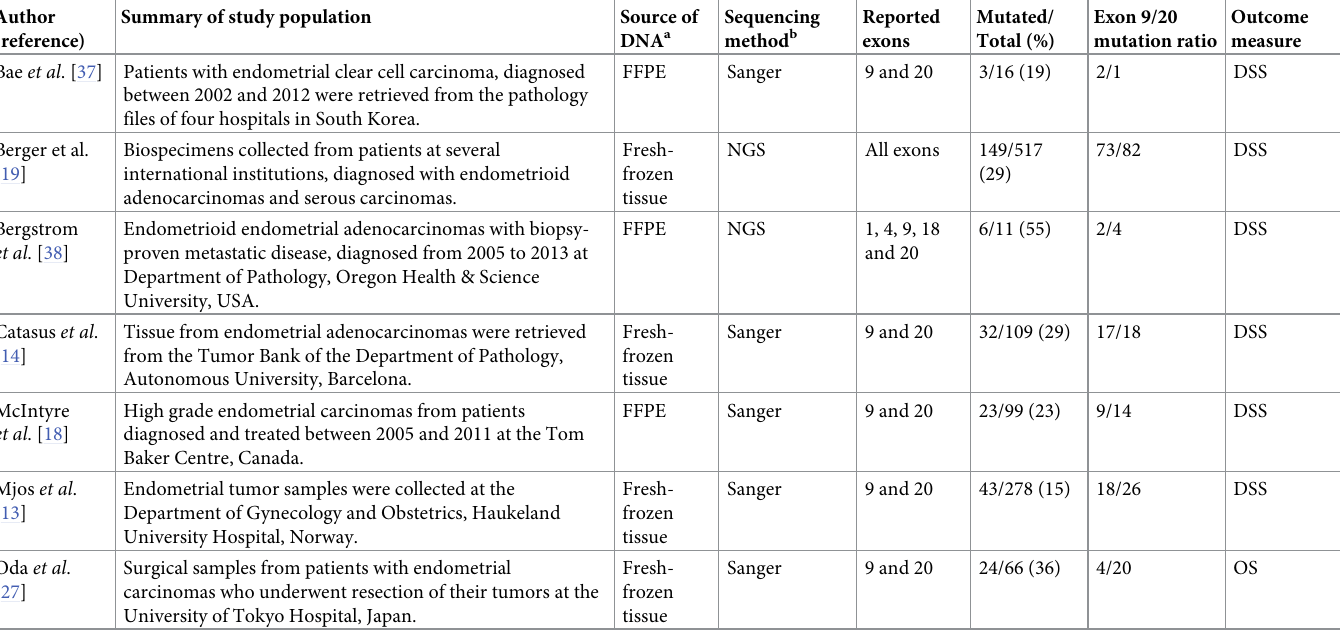
Table 1. Summary of included